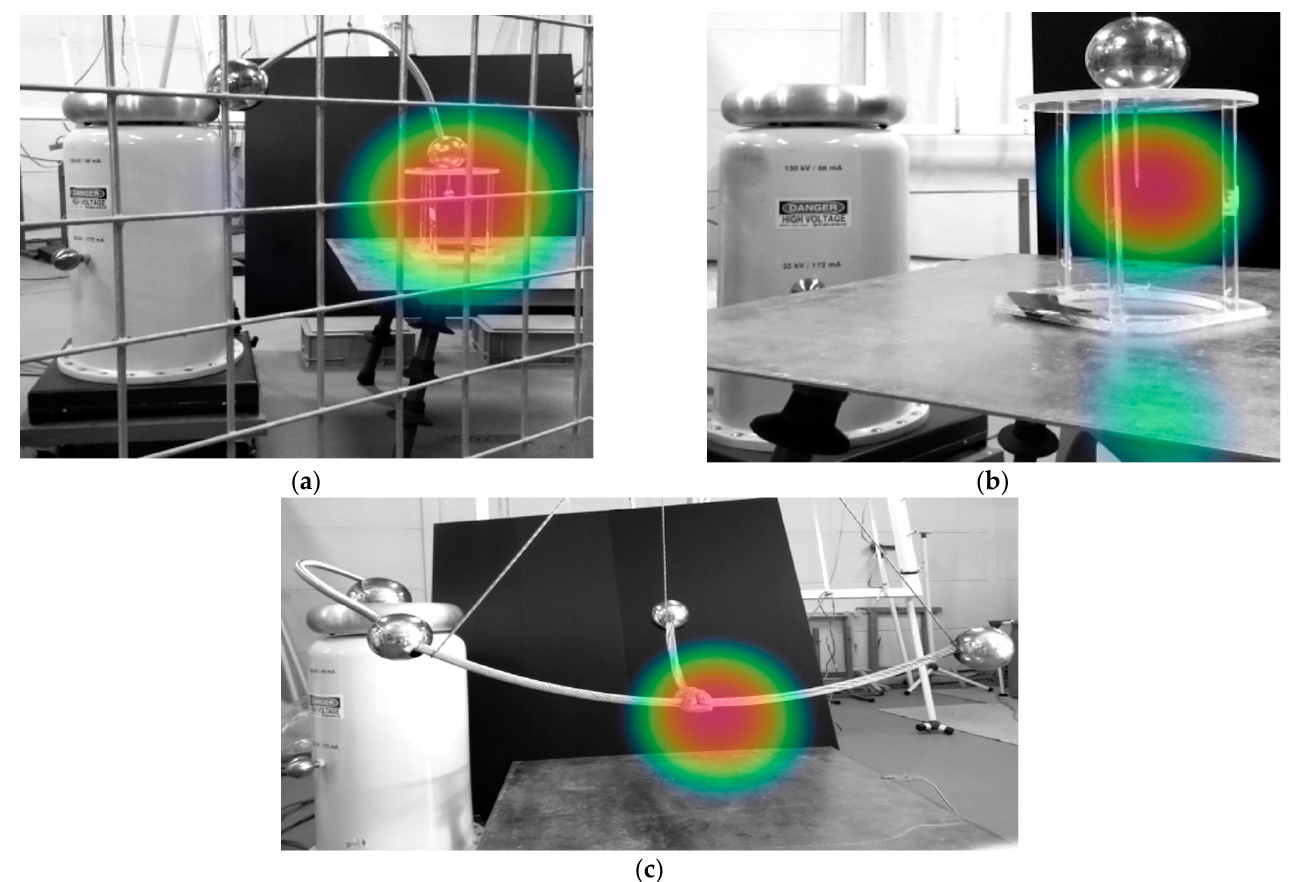
Figure 8. Photographs that were taken with the acoustic NL camera. ( a ) Sphere-plane gap at 2 m. ( b ) Needle-plane gap at 1 m. ( c ) Substation connector at 1 m. Table 3. CIV values that were obtained with the sphere-plane gap.